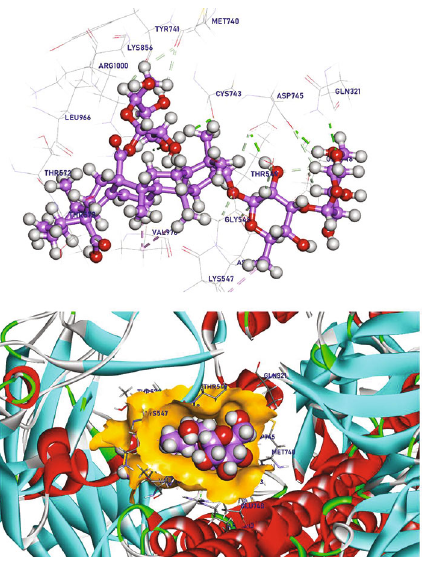
Figure 13: Quinovic acid docked in RBD-SARS-CoV-2 Omicron spike protein, hydrogen bonds (green), and the pi interactions are represented in purple lines.